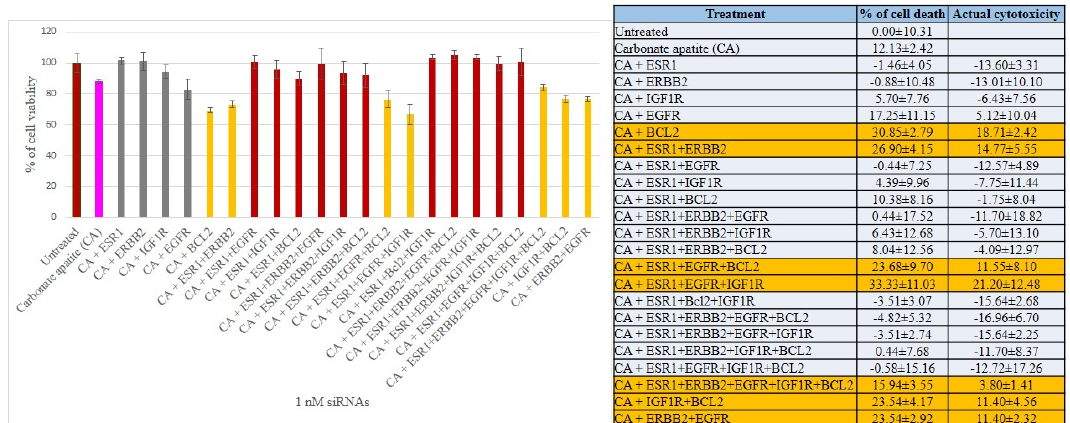
Figure 4. Cell viability and cytotoxicity assessments of MDA ‐ MB ‐ 231 cells treated with various CA ‐ siRNA complexes involving ESR1, ERBB2, IGF1R, EGFR and BCL2 siRNAs (1 nM) individually or in combination, for a period of 48 h. Preparation of the CA ‐ siRNA(s) complexes involved introduction of ESR1, ERBB2, IGF1R, EGFR and BCL2 siRNAs individually or in combination with 3.5 mM of CaCl 2 to 1 mL of bicarbonate ‐ buffered DMEM (pH 7.4). The mixture was allowed incubation at 37 °C for 30 min before the addition of 10% FBS. The cells were incubated for the next 48 h with the prepared complexes. MTT assay was performed and absorbance reading was taken at 595 nm with 630 nm as references wavelength. Data was presented as mean ± SD of triplicates.